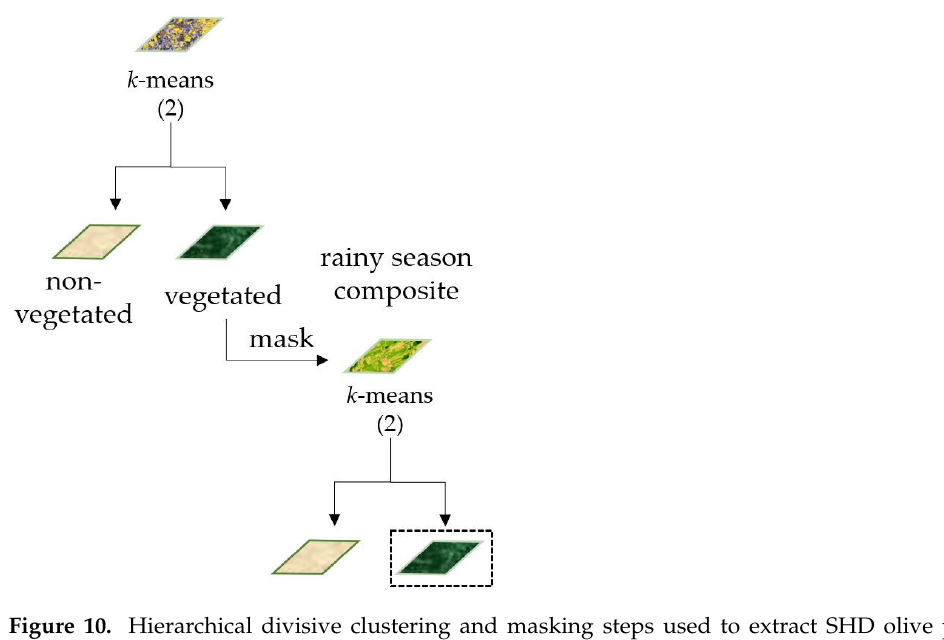
Figure 10. Hierarchical divisive clustering and masking steps used to extract SHD olive plantations using a two-cluster k -means algorithm on two HR seasonally representative processed satellite images.